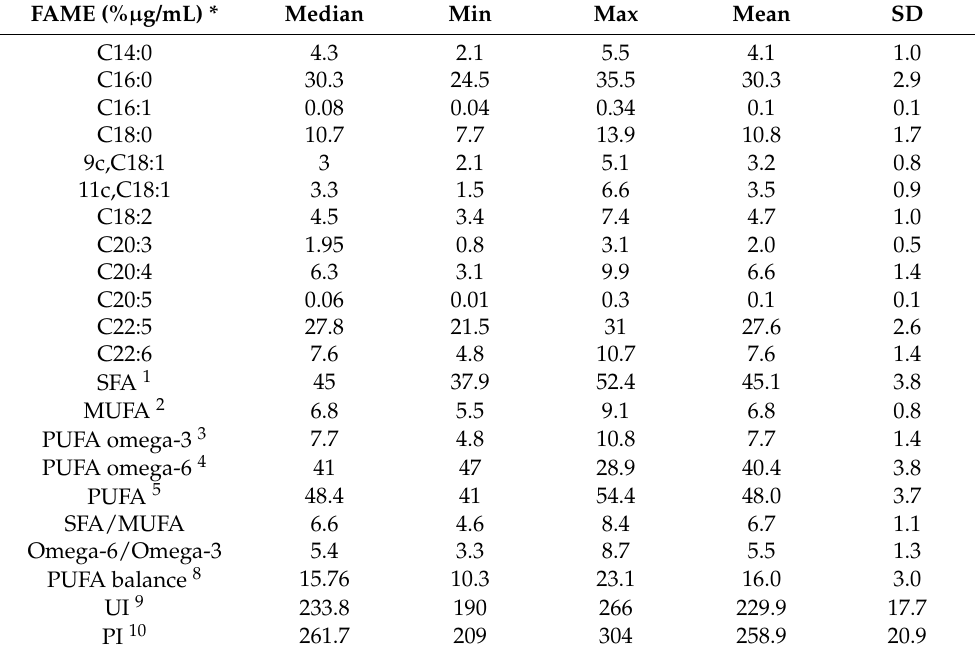
* The values are expressed as percentage of the found quantities (calculated as µ g/mL) ± standard deviation (SD) obtained from the gas chromatographic analyses, using calibration and quantitation protocols and standard reference compounds for each FAME. The GC peak areas of the 12 fatty acids cohort corresponds to ca. 97% of the total peak areas of the chromatogram. 1 SFA (Saturated Fatty Acids) = %C14:0 + %C16:0 + %C18:0. 2 MUFA (Monounsaturated Fatty Acids) = %C16:1 + %9c,C18:1 + %11c,C18:1. 3 PUFA (Polyunsaturated Fatty Acids) omega-3 = %C20:5 + %C22:6. 4 PUFA (Polyunsaturated Fatty Acids) omega-6 = %C18:2 + %C20:3 + %C20:4